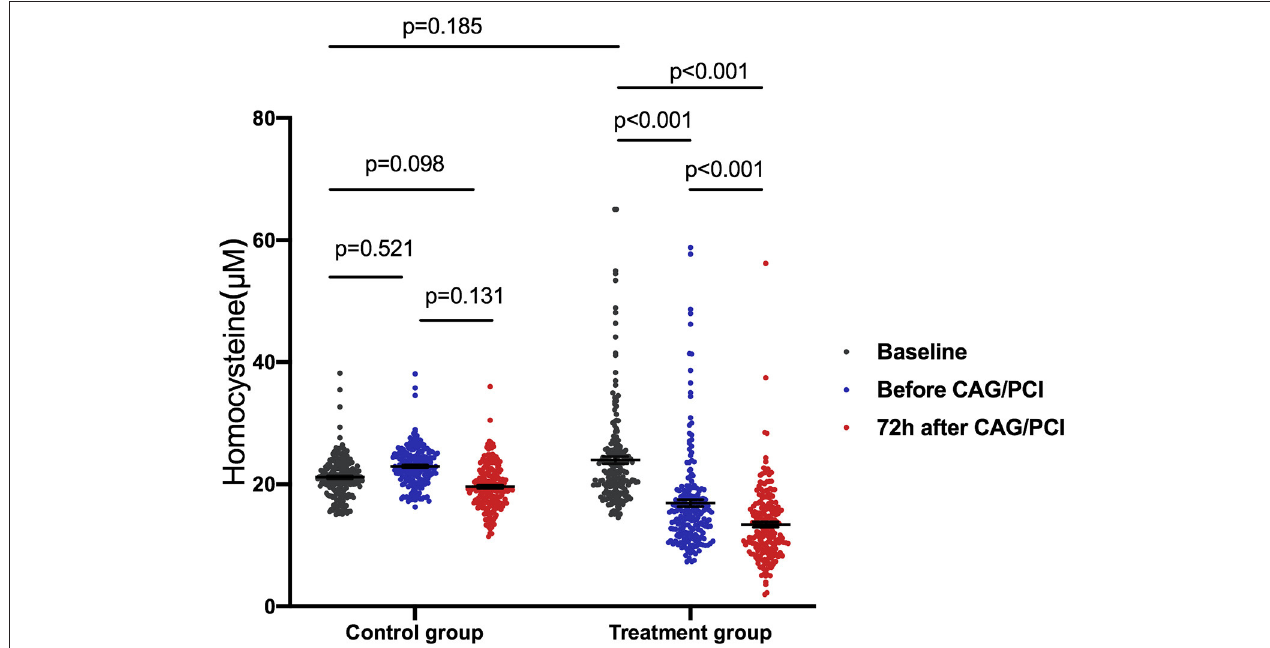
FIGURE 2 | Homocysteine (Hcy) change over time in patients with hyperhomocysteinemia receiving folic acid and the control group. One-way ANOVA was used to analyze intergroup differences with a Bonferroni multiple comparison post-test. P < 0.0167 were considered statistically significant. The linear mixed model showed significant differences in the change in Hcy concentration between the two groups due to the interaction between the groups and time ( P < 0.001). The folic acid group showed a faster decline. The average of the control group was 0.81 lower than that of the folic acid group at baseline, 6.02 higher than that of the folic acid group before procedure, and 9.05 higher than that at 72h after procedure. ANOVA, analysis of variance; CAG, coronary arteriography; PCI, percutaneous coronary intervention.